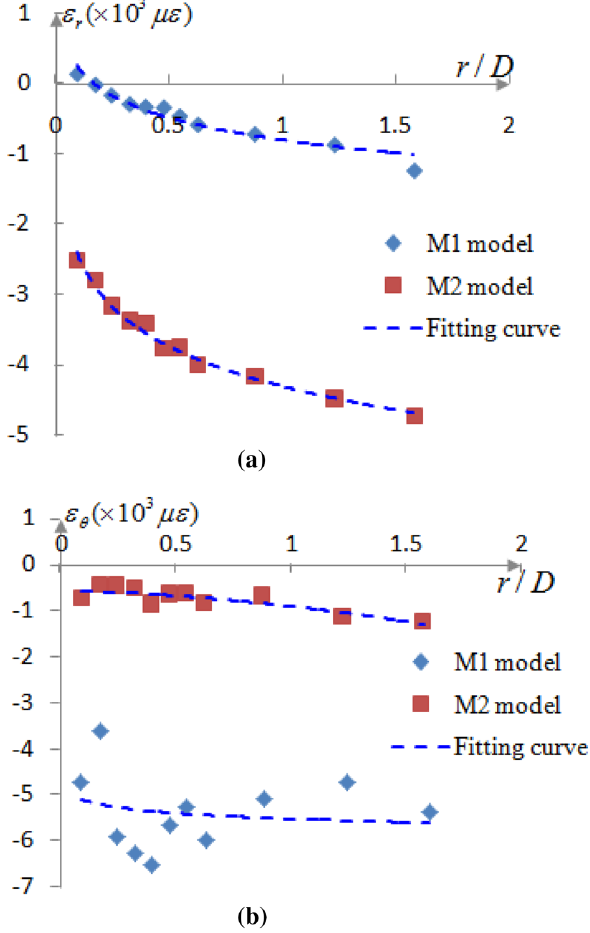
Fig. 14 a Radial and b circumferential strain curves at the top of the vaults in the M1 and M2 models under the maximum